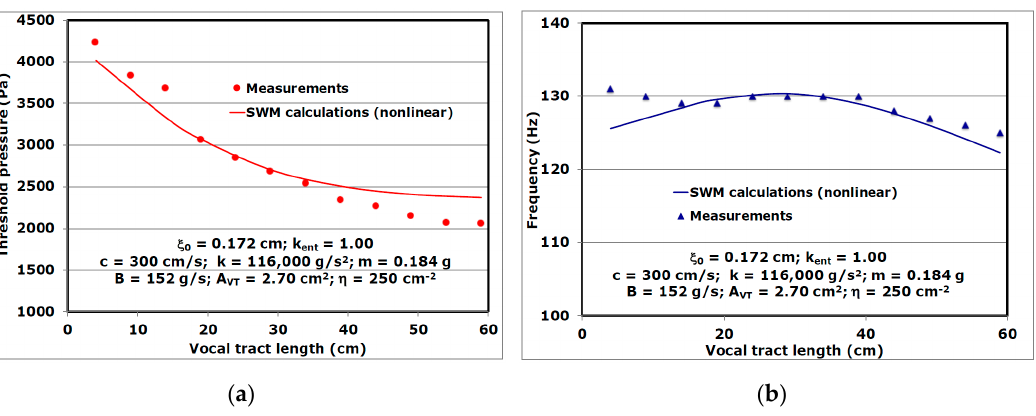
Figure 11. (Color online) ( a ) Measured and calculated threshold pressures for model 113 as a function of vocal tract length. ( b ) Measured and calculated frequencies as a function of vocal tract length.